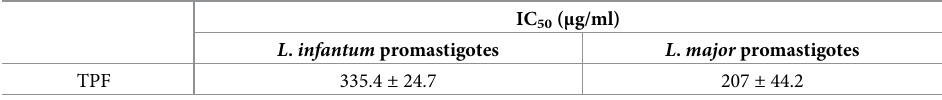
Table 1. Half-maximal inhibitory concentrations (IC 50 values) of TPF against L . infantum and L . major